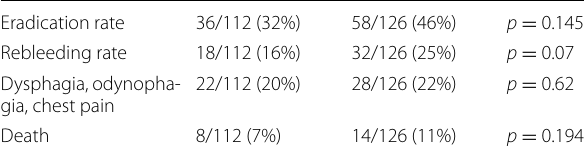
Table 2 Outcome of endoscopic